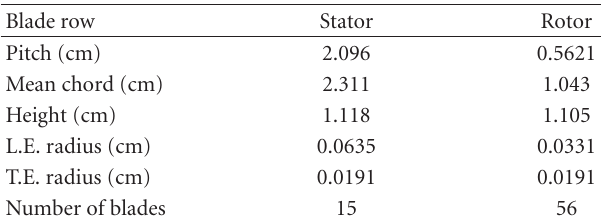
Table 1: NASA-designed automotive turbine (TMX-71717) blade geometry.